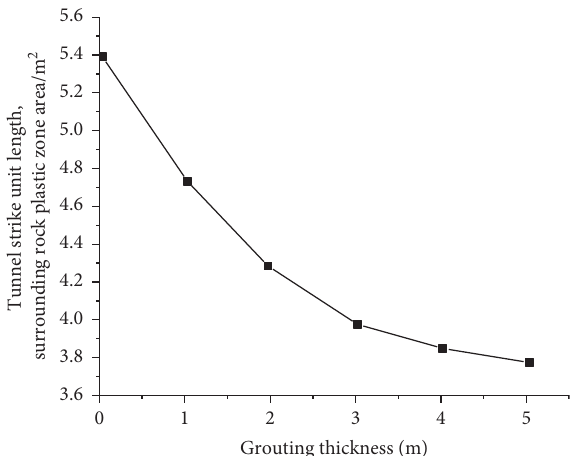
Figure 8: Area of plastic zone of surrounding rock under the action of different grouting